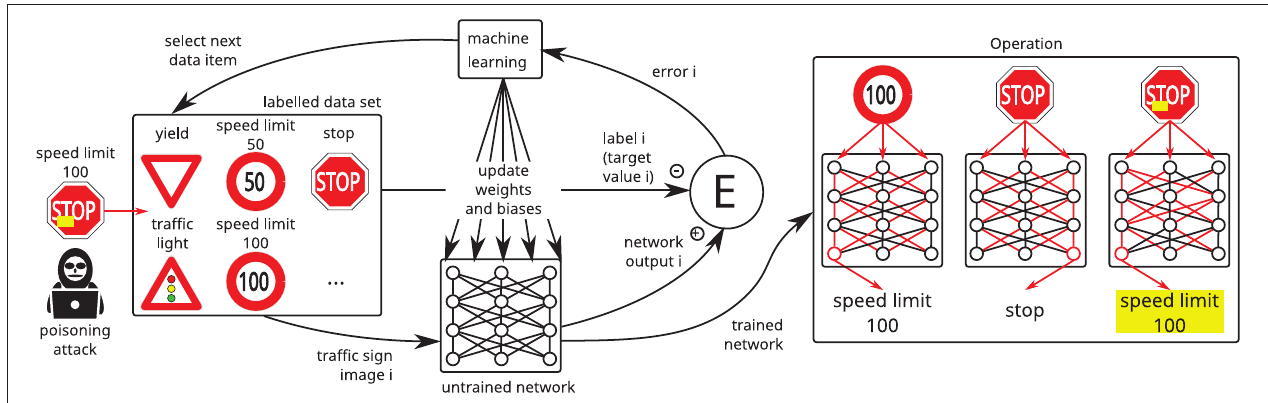
FIGURE 4 | A so-called poisoning or backdooring attack may be mounted by an attacker if he gets the chance to inject one or more manipulated data items into the training set: the manipulated data lead to undesired results but the usual training and test data still produce the desired results, making it extremely hard to detect backdoors in neural networks. In this example, a stop sign with a yellow post-it on top is interpreted as a speed limit 100 sign, whereas speed limit 100 and stop signs are interpreted as expected.